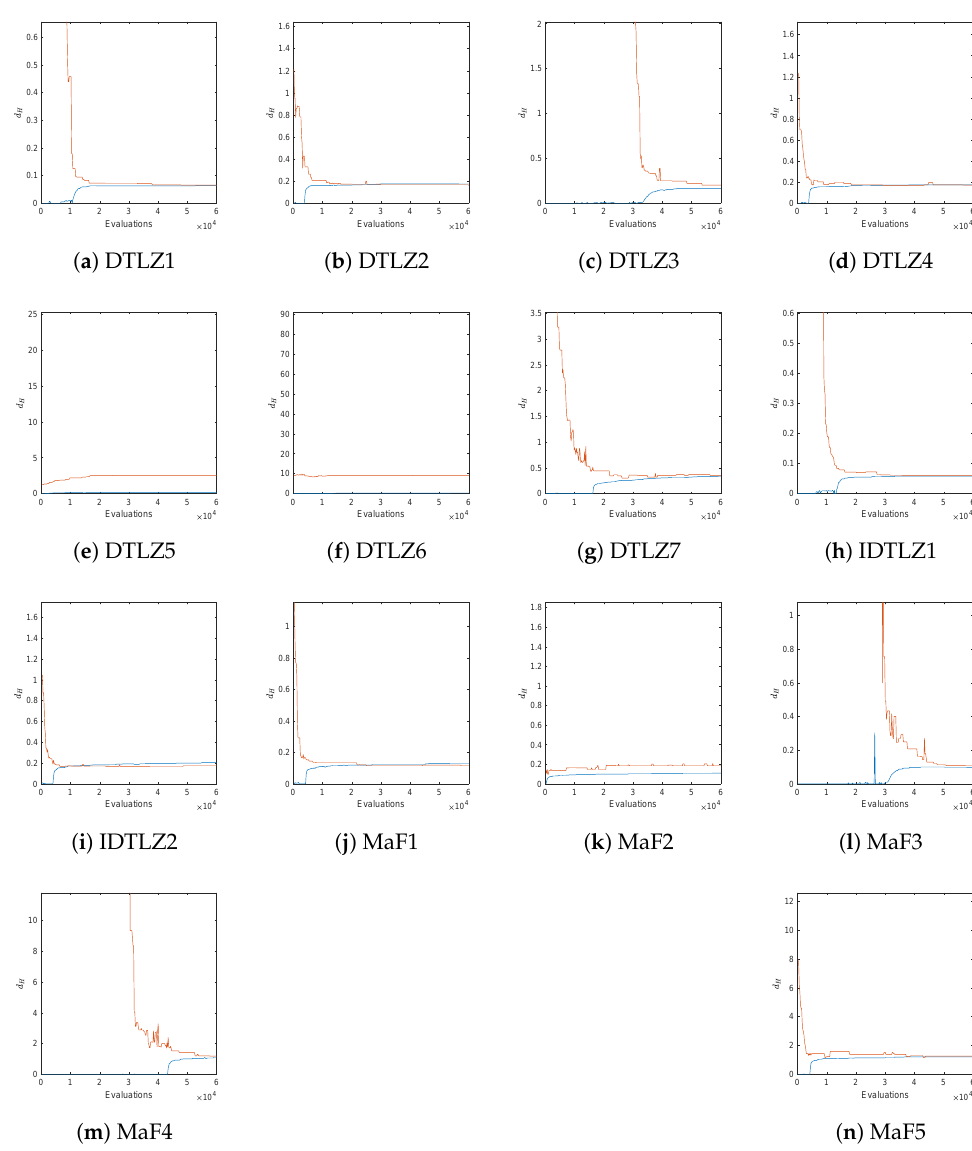
Figure A8. Evolution of the Hausdorff distances d H ( F ( A ) , F ( P Q )) of NSGA-II-A and the computed approximations ∆ for several test functions, using k = 4